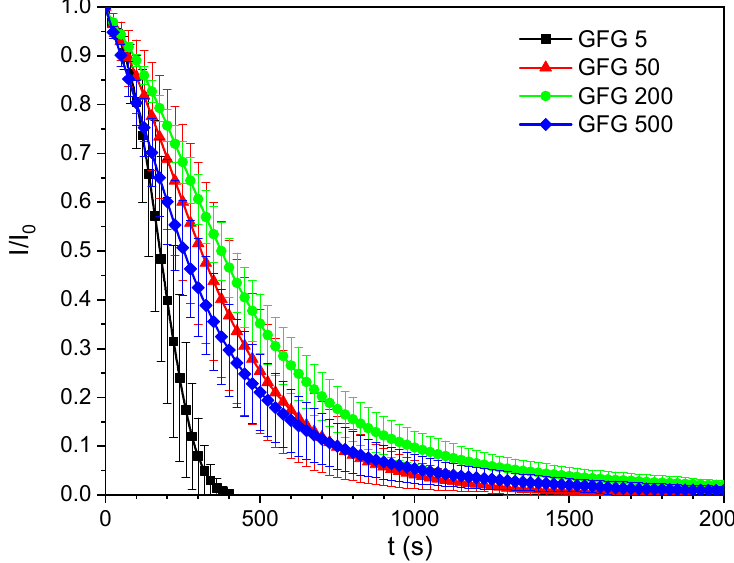
Figure 4. Change of relative current I / I 0 with time t for di ff erent filler particle sizes with data points corresponding to mean values and their standard deviation values (error bars) from three experiments.